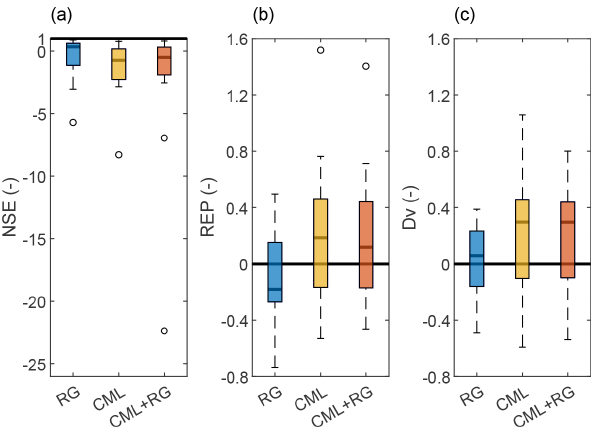
Figure 10. Panels (a) to (c) show box plots of performance metrics, namely the respective NSE, REP, and Dv, for the 12 selected flood events. The optimum values correspond to the bold black lines. The box plots display the median, the 0.25 (lower) and 0.75 (upper) quantiles, outliers (computed using the interquartile range), and the minimum and maximum values excluding any outliers.